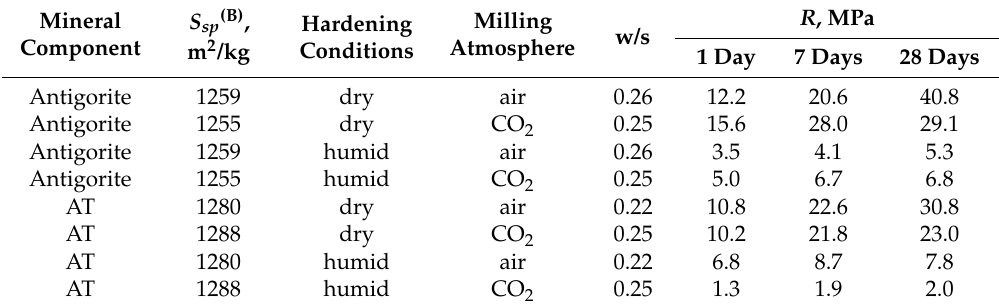
Table 4. Compressive strengths ( R ) of alkali-activated binders prepared using antigorite or antigorite- containing ore dressing tailings (AT) milled for 600 s in moderate conditions and liquid glass with a modulus of 2.25. The specific surface area ( S sp (B) ) was measured using the Blaine method. The amount of liquid glass added corresponded to 3% Na 2 O. (w/s: water to solid ratio).